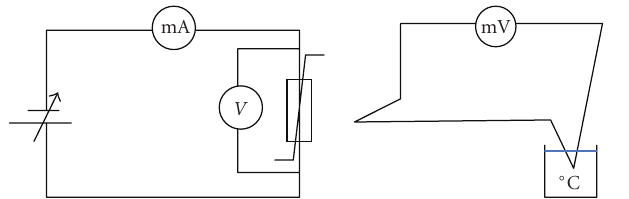
Figure 1: The schematic of varistor in the circuit and measurement of its temperature.